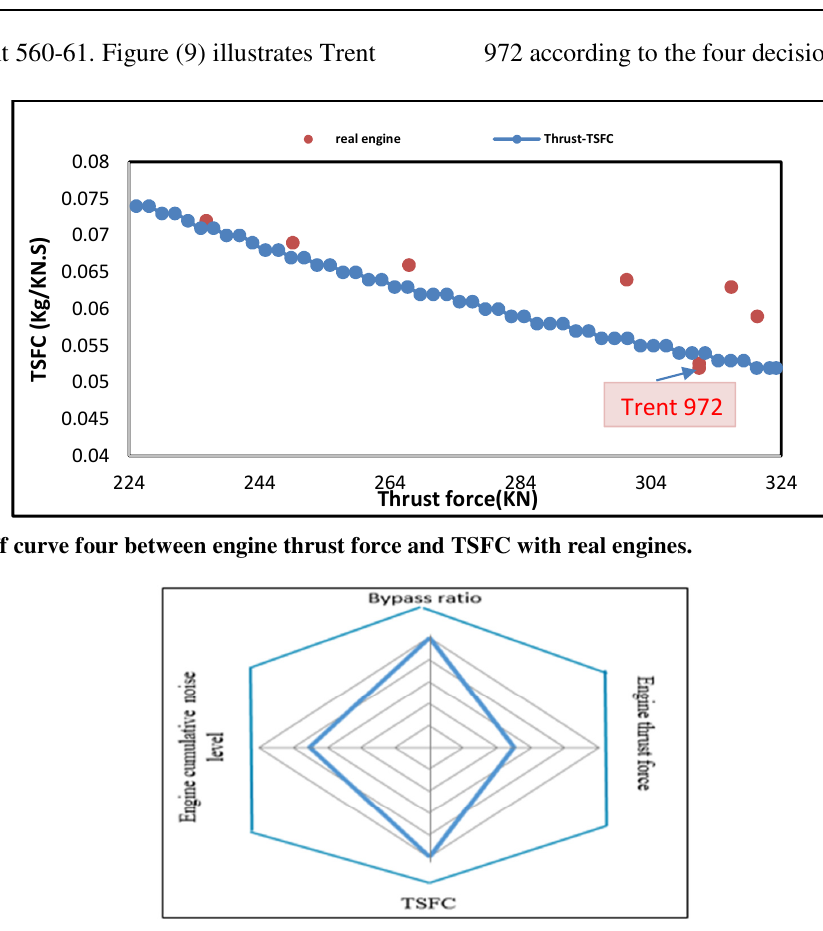
Fig. 9. Trent 972 optimum solution according to engine thrust force and TSFC.